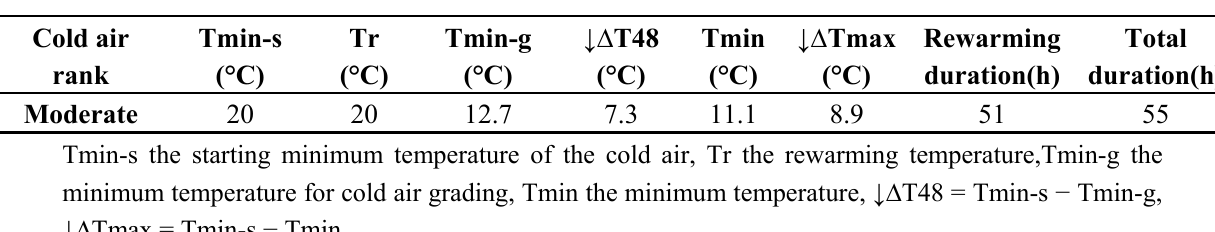
Table 1. Details of ther cold